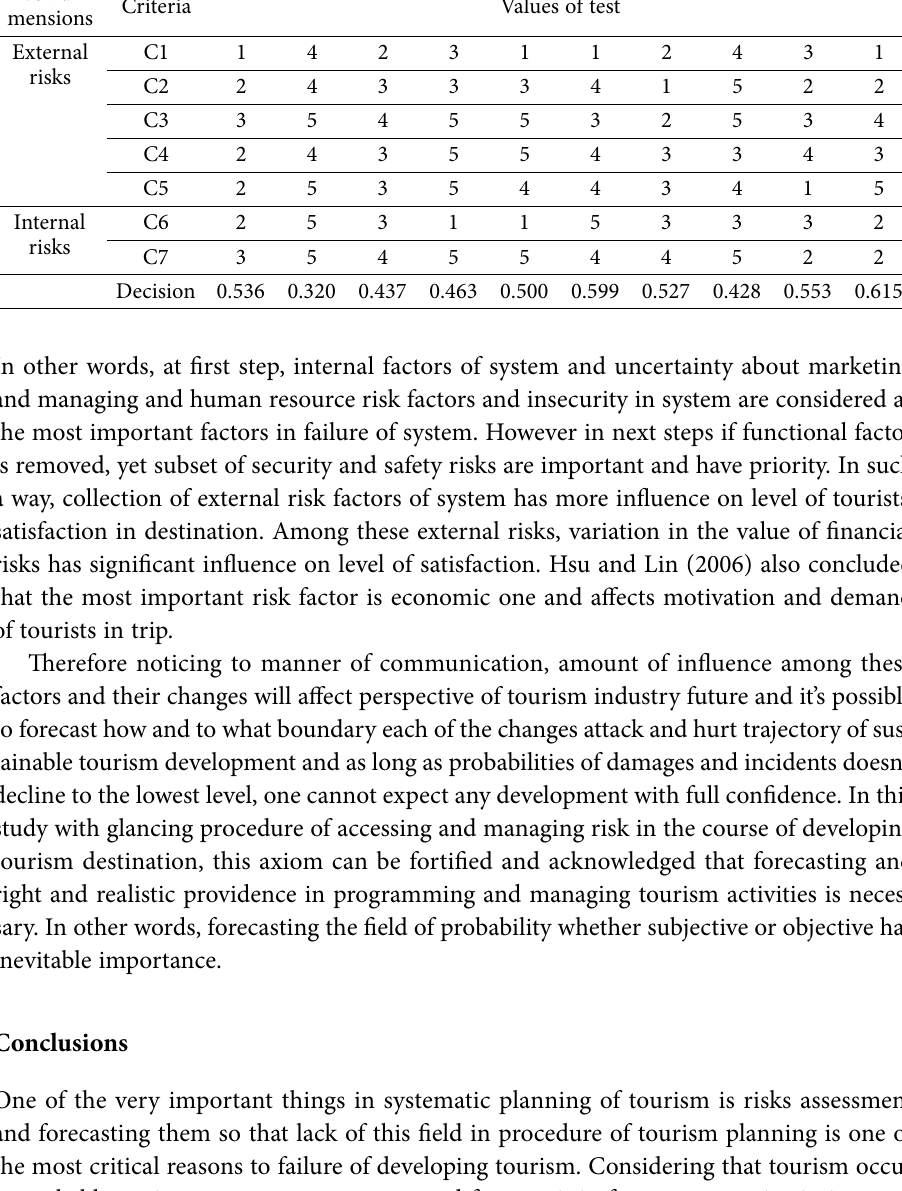
Table 6. Sensitivity analysis of tester’s opinions Risk di-